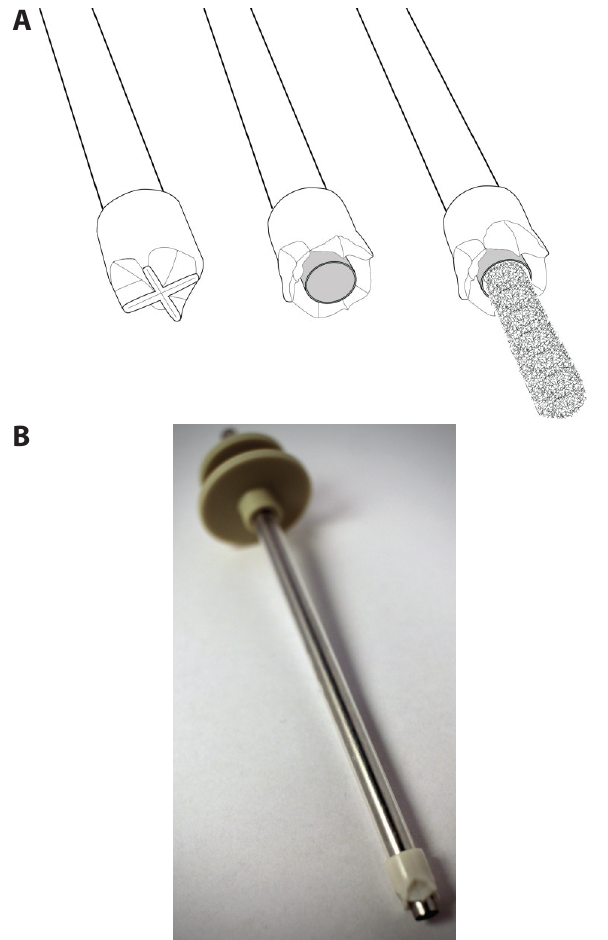
Figure 1. Graphic illustration of the CFS device. (A) Drawings of the CFS device in the closed and open configuration. (B) A picture of the proto-